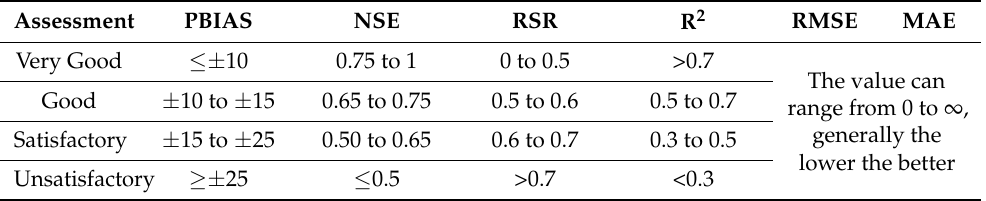
Table 3. Summary of Statistical Criteria limits